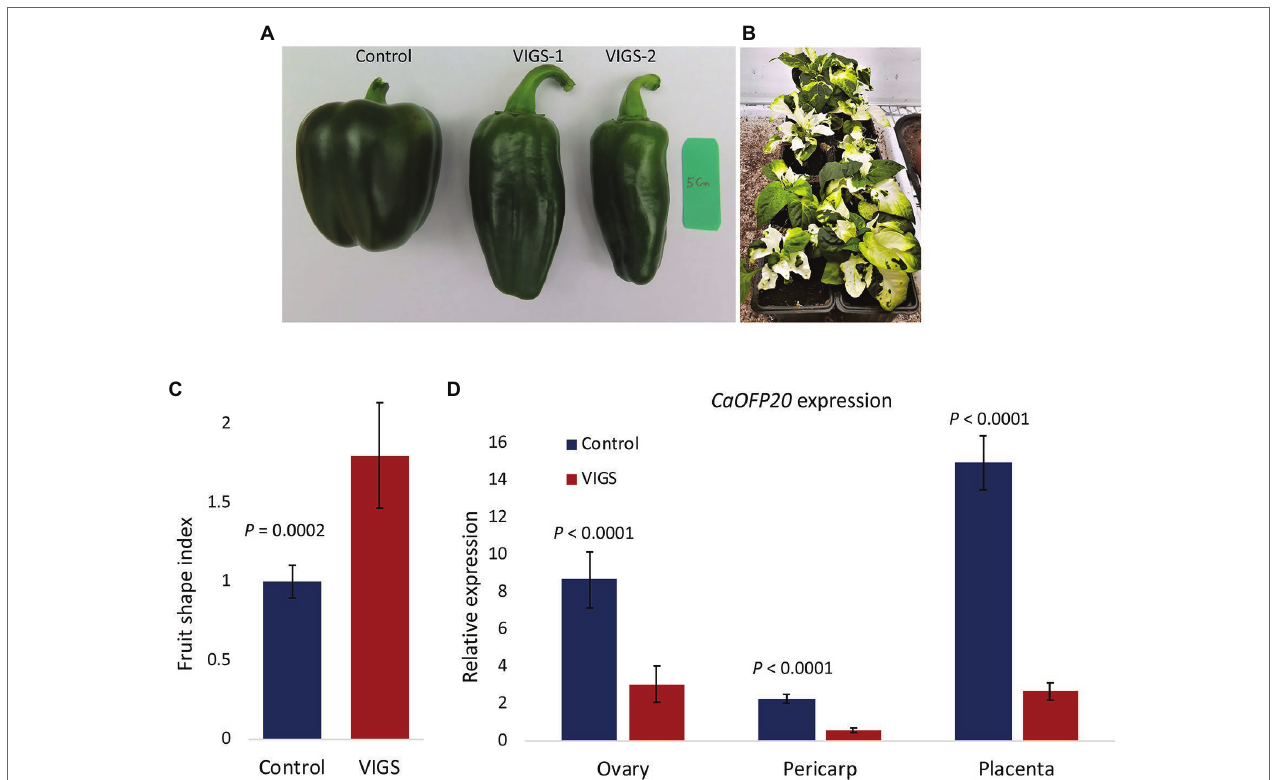
FIGURE 5 | Silencing of CaOFP20 in cv. Maor by VIGS. (A,C) Silencing of CaOFP20 results in fruit elongation. Control – inoculation with empty vector. VIGS-1 and VIGS-2 are examples of silenced fruit 3 weeks after anthesis. (B) Silencing CaPDS as a positive control. Silenced plants did not set fruits. (D) Expression of CaOFP20 is downregulated in silenced elongated fruit. Significant differences between the silenced and control fruit were determined by Student’s t